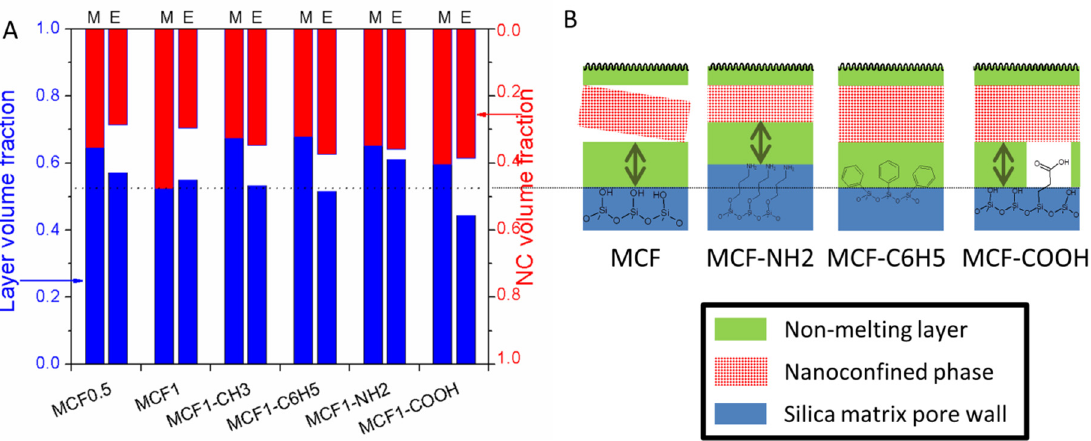
Figure 12. ( A ) Modeled (M) and experimental (E) volume fractions of the non-melting layer, nanoconfined SA and empty pores and ( B ) schematic representation of the pristine and functionalized pore composition. Adapted with permission. Ref. [66]. Copyright Elsevier B.V. 2019.